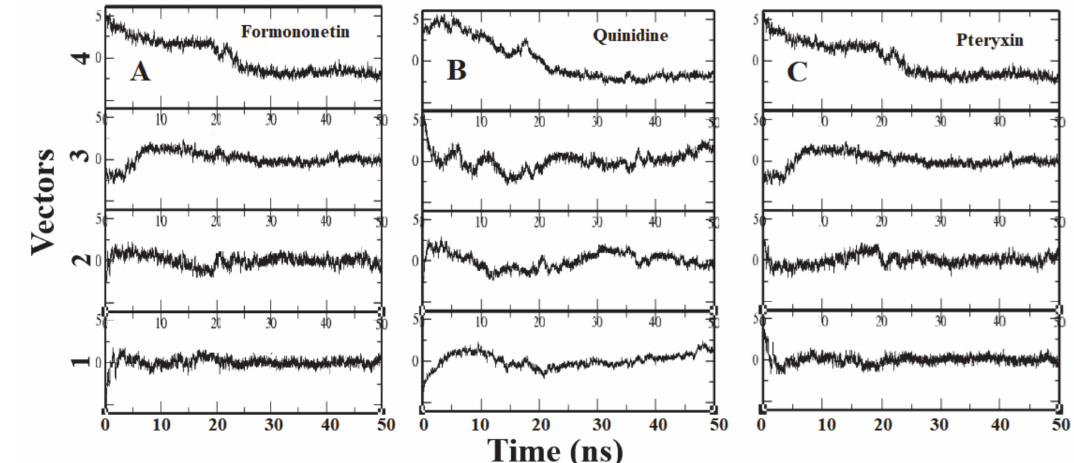
Figure 7. Each panel ( A – C ) reports the calculation of projection of particular trajectory on eigenvectors for each three complexes. The RMSDs for every four eigenvectors are depicted as four subplots in each panel. Plot shows the projections of each vector are fitted to the structure in the eigenvector.